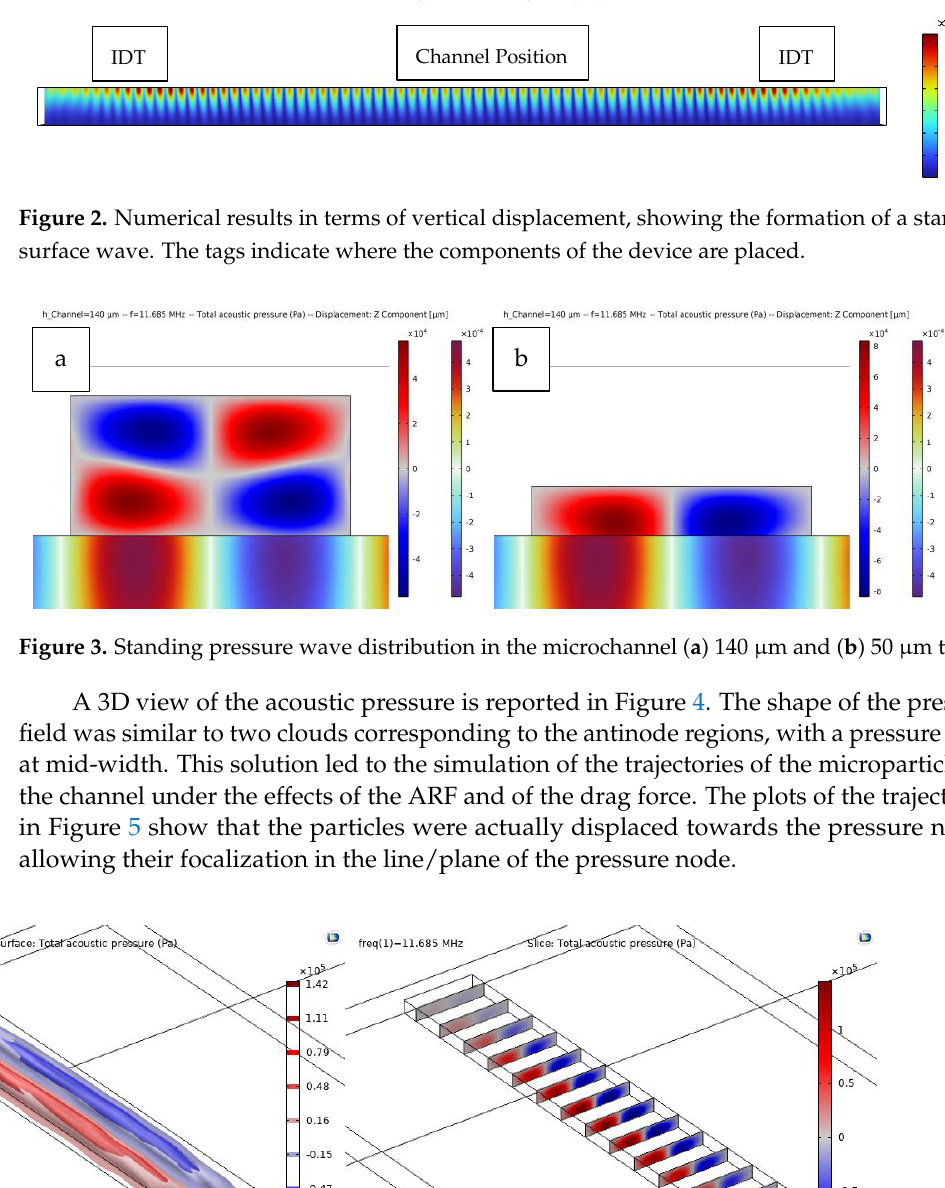
Figure 2. Numerical results in terms of vertical displacement, showing the formation of a standing surface wave. The tags indicate where the components of the device are placed.